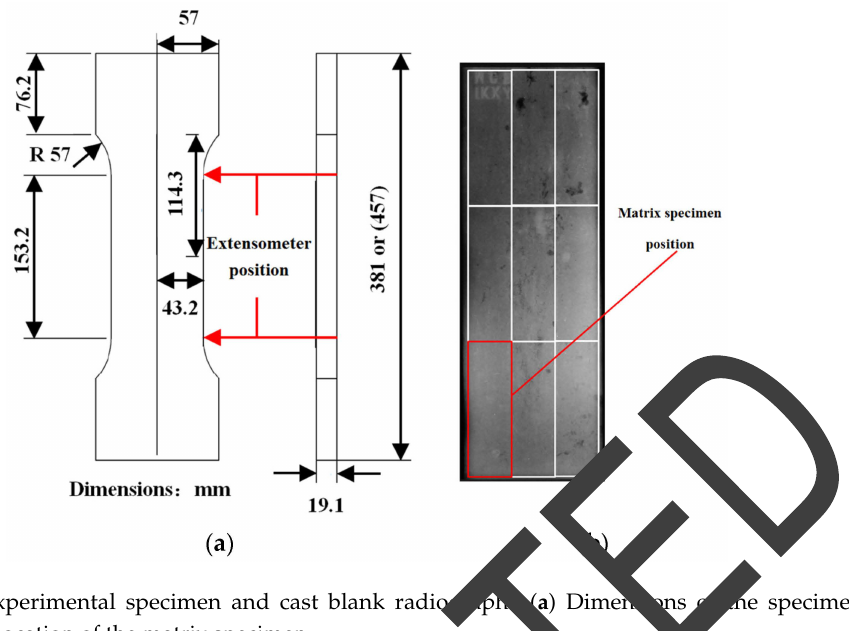
Figure 2. Experimental specimen and cast blank radiograph: ( a ) Dimensions of the specimen; ( b ) Selecting location of the matrix specimen.